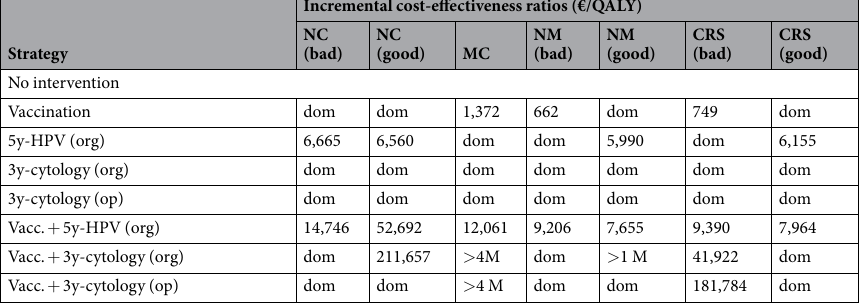
Table 3. Incremental cost-effectiveness ratios by calibration approach and input matrix. NC = No calibration, MC = Manual calibration, NM = Nelder-Mead, CRS = Controlled random search. dom = weakly dominated